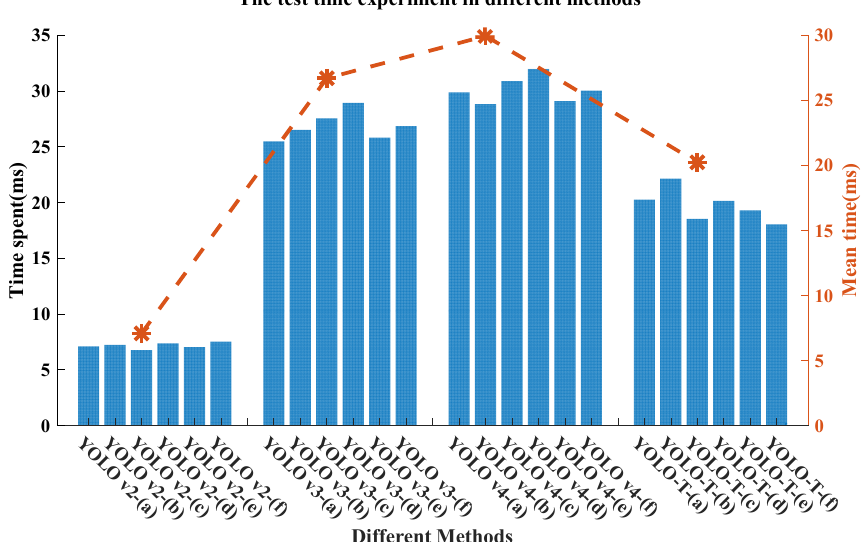
Figure 14. Detection time experiment results obtained by different methods.